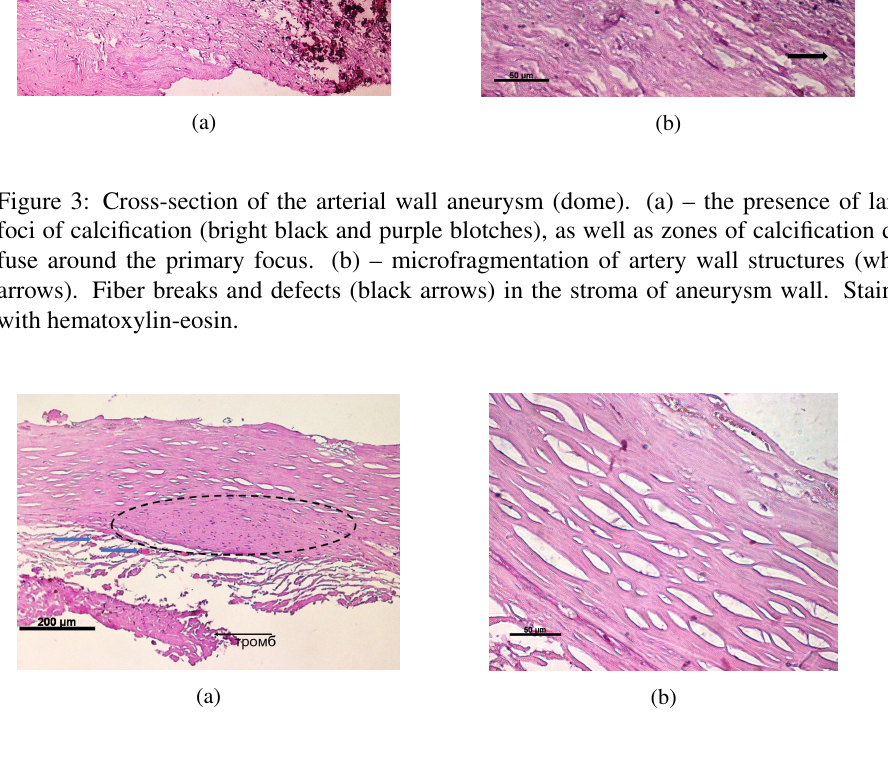
Figure 4: Cross-section of arterial wall aneurysm (neck): a) zone of intact cellularity (contour dotted) and microvessels (blue arrows); b) loss of fiber structure, aneurysm wall decellular- ization. Stained with